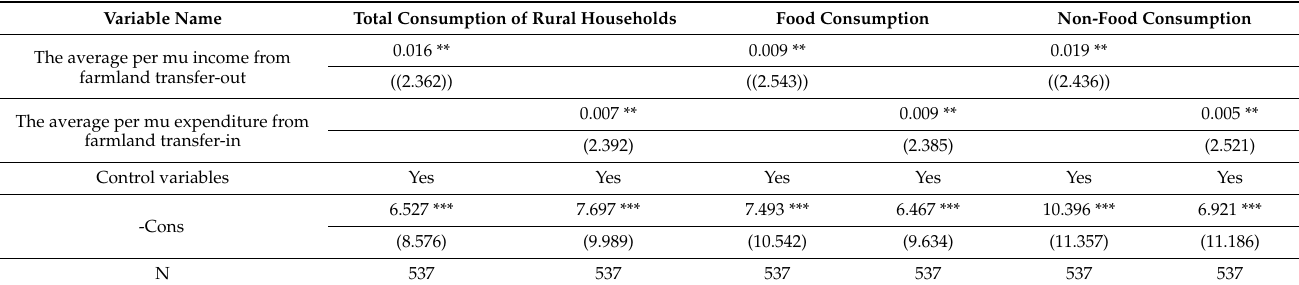
Table 5. Robustness test II: Replacement of core explanatory